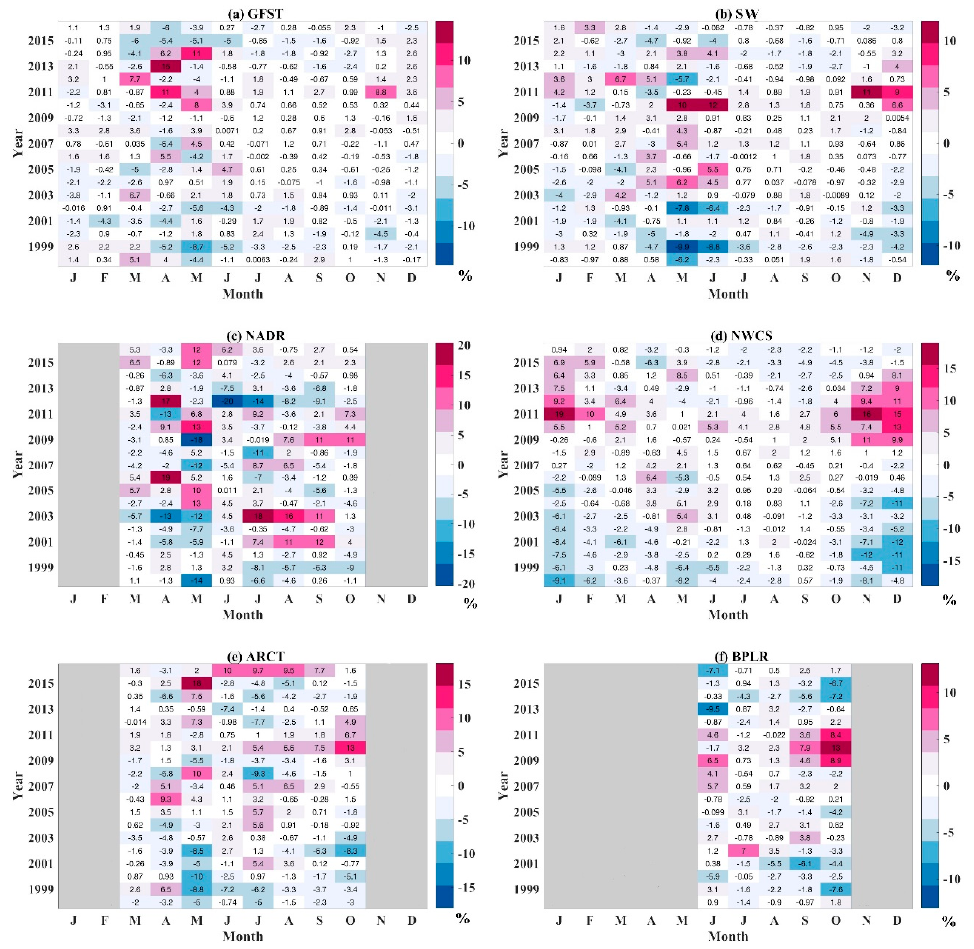
Figure 12. Monthly anomaly heatmaps for fractions of microphytoplankton in ( a ) Gulf Stream, ( b ) Slope Waters, ( c ) North Atlantic Drift, ( d ) Northwest Continental Shelf, ( e ) Arctic Waters, and ( f ) Polar Boreal Current. Values in each cell are anomalies from the mean of each month in the whole study period (1998–2016). Cells in red indicate higher than normal levels; Cells in blue indicate lower than normal levels. A blank cell indicates low valid pixel percentage (<60%) due to ice or cloud cover.